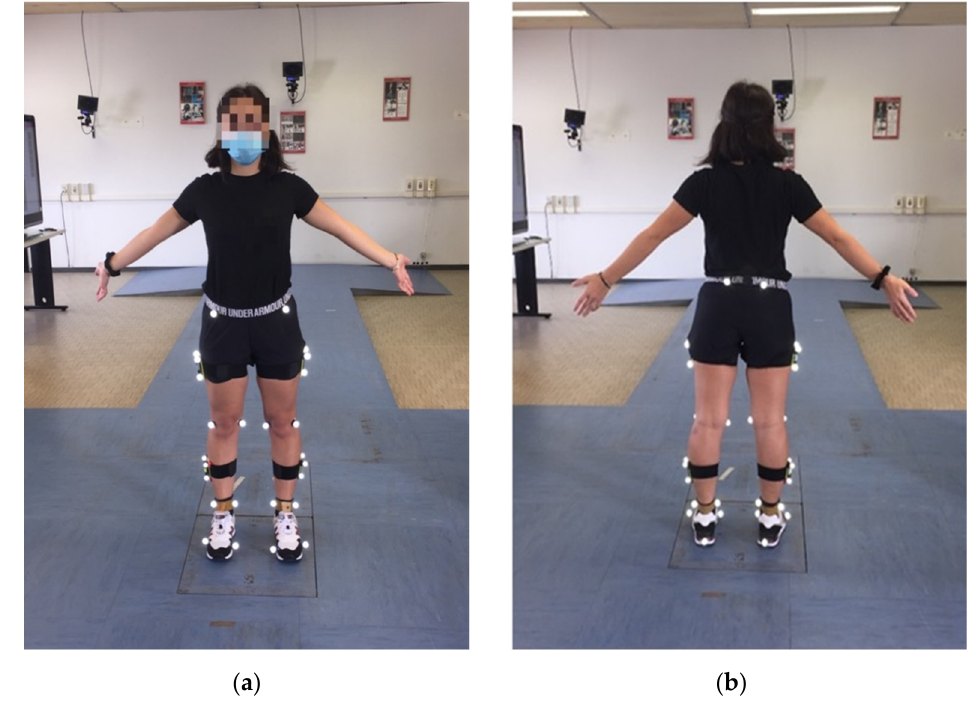
Figure 1. Subject equipped with the marker set used in the study: ( a ) front and ( b ) back view. Landmarks’ position was manually determined by palpation, by identifying regions with reduced thickness of the tissues interposed between bone and skin. According to this approach, 18 markers were bilaterally placed on the superior-anterior iliac spine, posterior iliac crest, lateral and medial femoral epicondyle, lateral and medial malleolus, calcaneus and foot (corresponding to the 1st and 5th metatarsal heads).